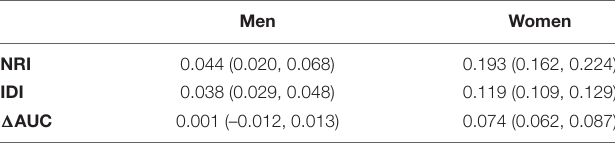
TABLE 3 | Improvement in risk prediction of PASAP-ILERVAS respect to SCORE